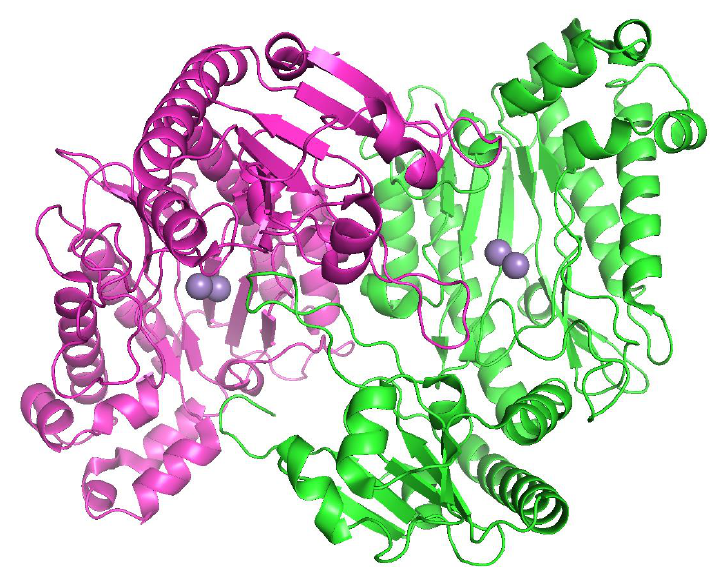
Figure 3. Organophosphate anhydrolase/prolidase from Alteromonas sp. (PDB ID 4ZWO, mutant Y212F, resolution 2.14 Å ) [88]: the two chains of the homo-dimer are coloured green and magenta; manganese ions are coloured violet.